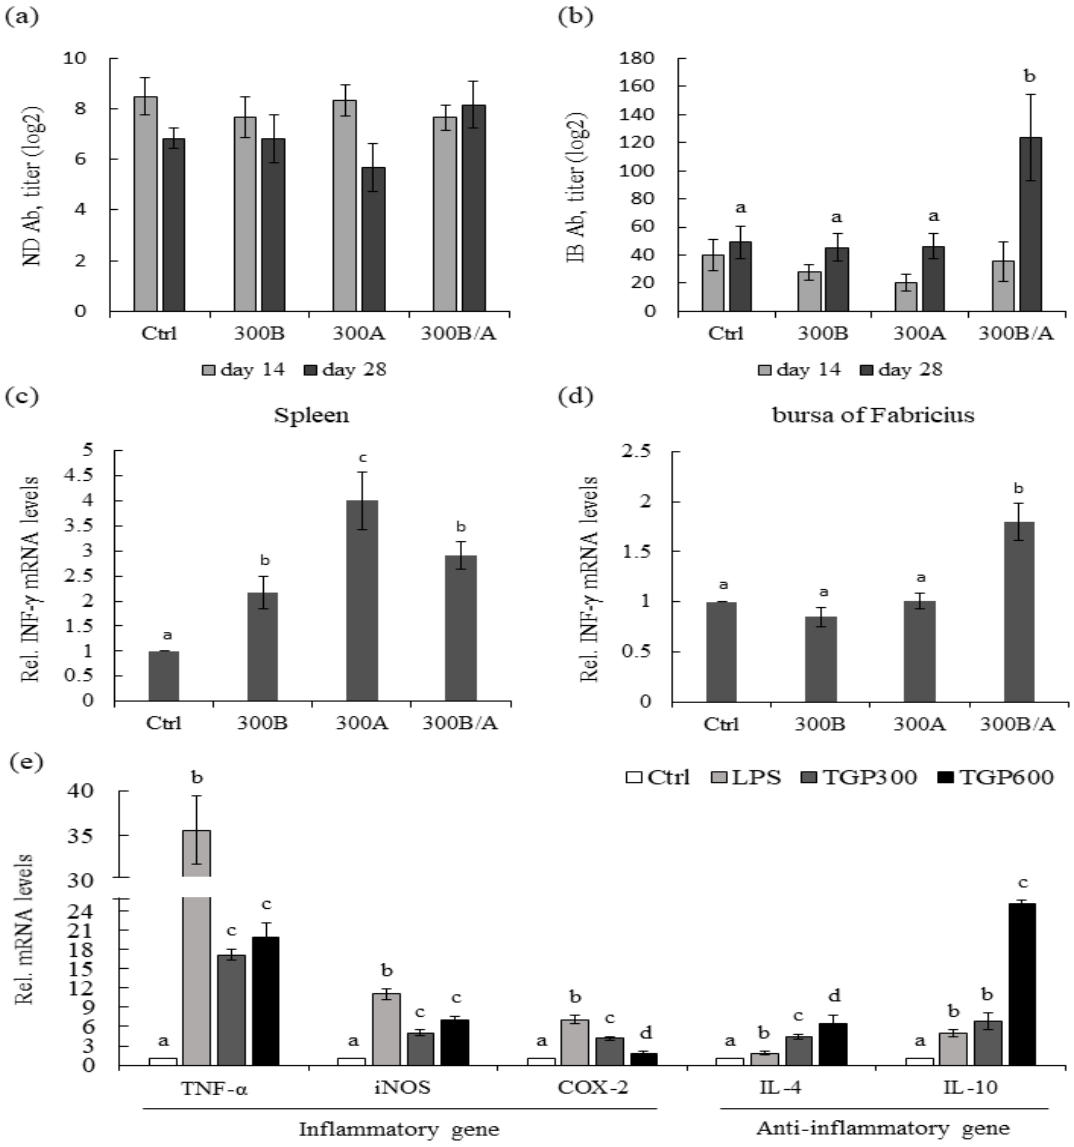
Figure 1. Effects of eTGP supplementation on the immunomodulatory effects in broilers. Effects of control (Ctrl) and 300 µg/mL eTGP supplemented before vaccination (300B), after vaccination (300A), and before and after vaccination (300B/A) on the serum ( a ) ND and ( b ) IB antibody titers of broilers at 14 and 28 days of age. Effects of Ctrl, 300B, 300A, and 300B/A on the IFN- γ mRNA expression in the ( c ) spleen and ( d ) bursa of Fabricius of broilers at 28 days of age. ( e ) Effects of supplementing eTGP on the various gene expression levels of TNF- α , iNOS, COX-2, IL-4, and IL-10 in the spleen of broilers challenged by LPS. Values are expressed as means ± standard deviation ( n = 3). The means with different letter superscripts are significantly different ( p < 0.05).